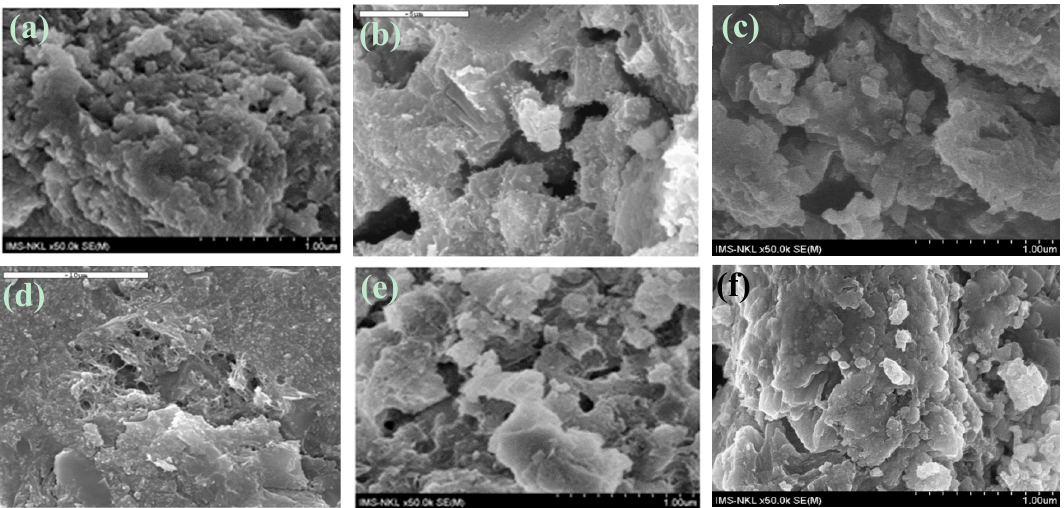
Figure 5. Scanning electron microscope (SEM) of cement paste specimens: ( a ) P-F30S0P0.4, 28 days; ( b ) P-F30S0P0.4, 56 days; ( c ) P-F25S5P0.4, 28 days; ( d ) P-F25S5P0.4, 56 days; ( e ) P-F15S15P0.4, 28 days; and ( f ) P-F15S15P0.4, 56 days.